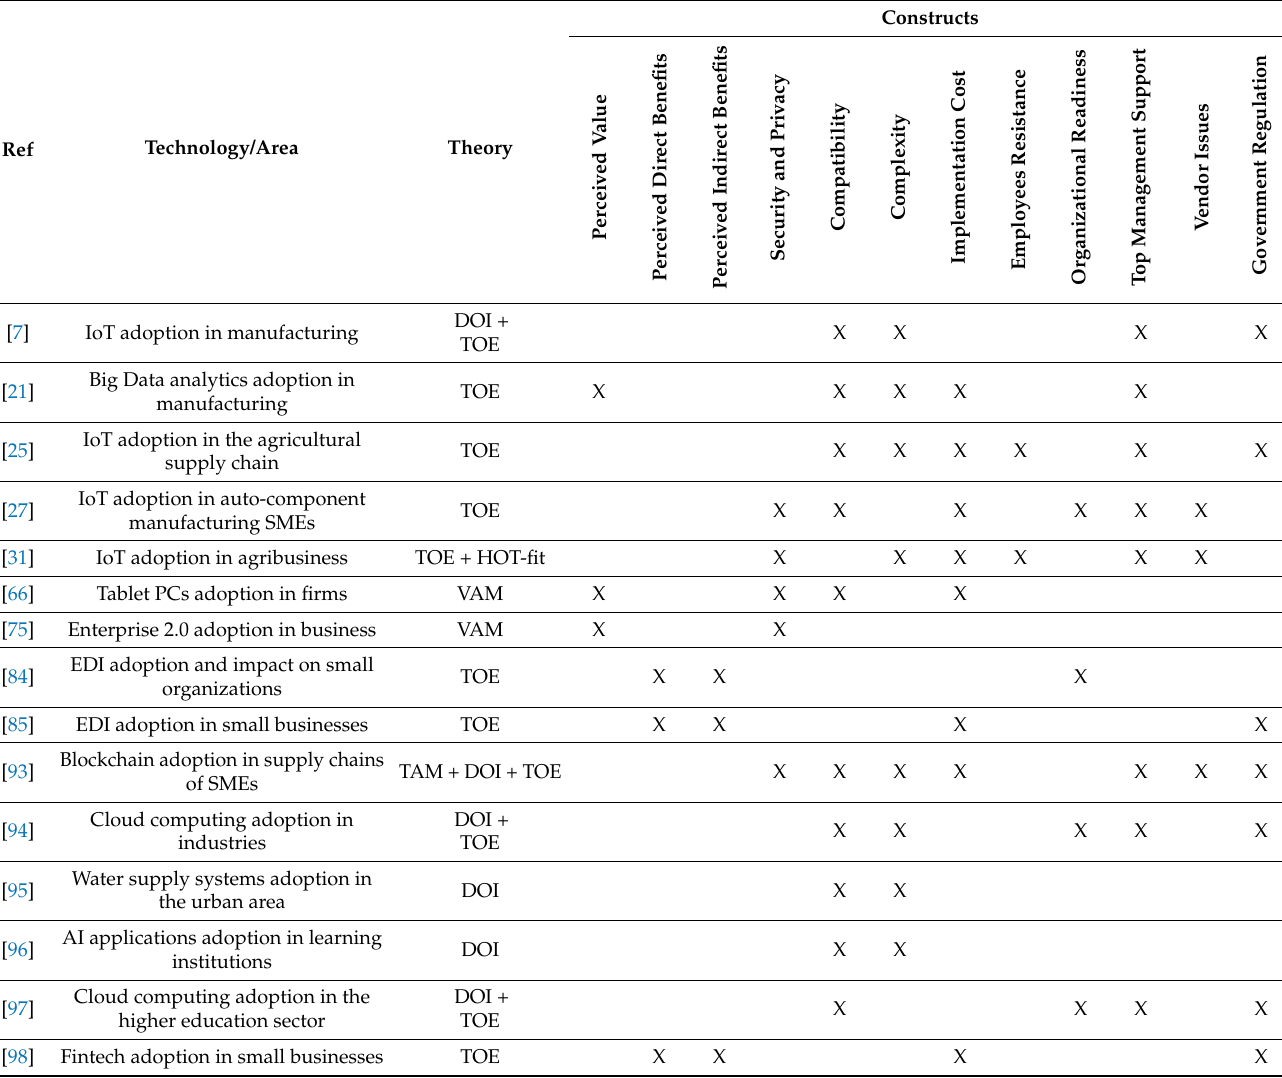
Table 1. Mapping matrix of VAM, DOI, and TOE constructs used in this